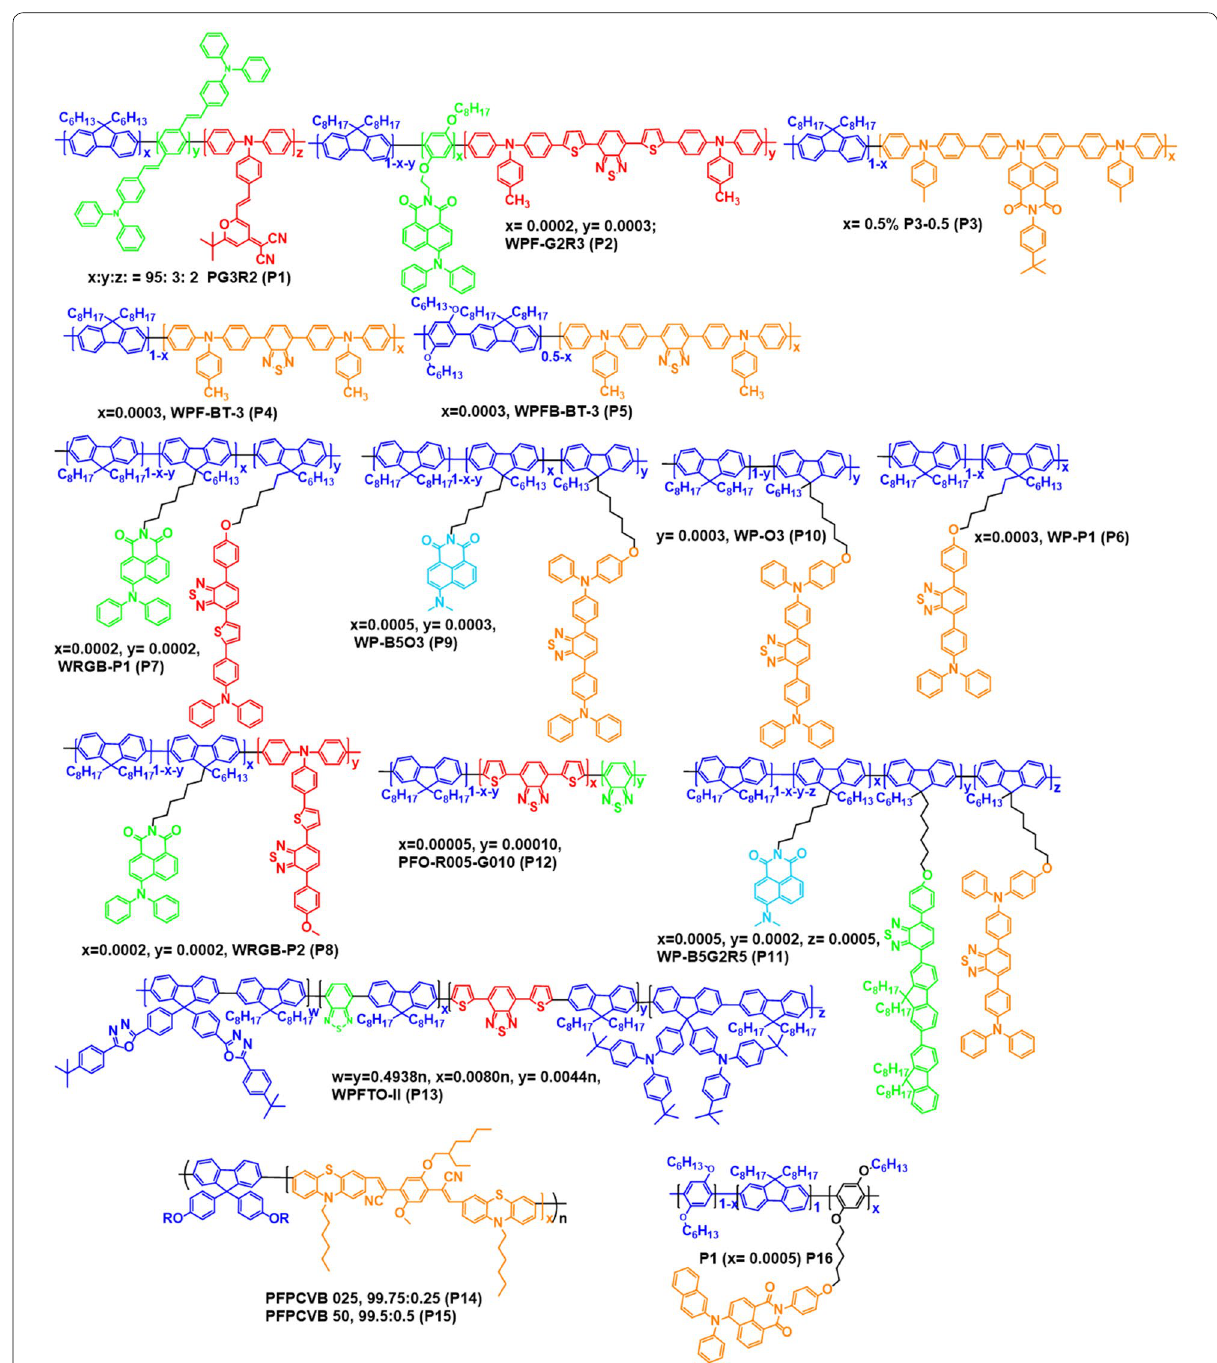
Fig. 10 Chemical structures of the single layer